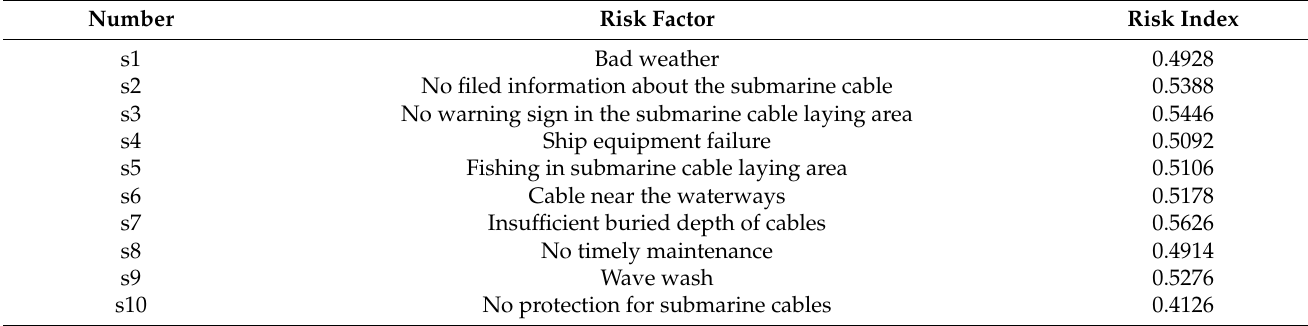
Table 8. Submarine cables’ risk factors of offshore wind